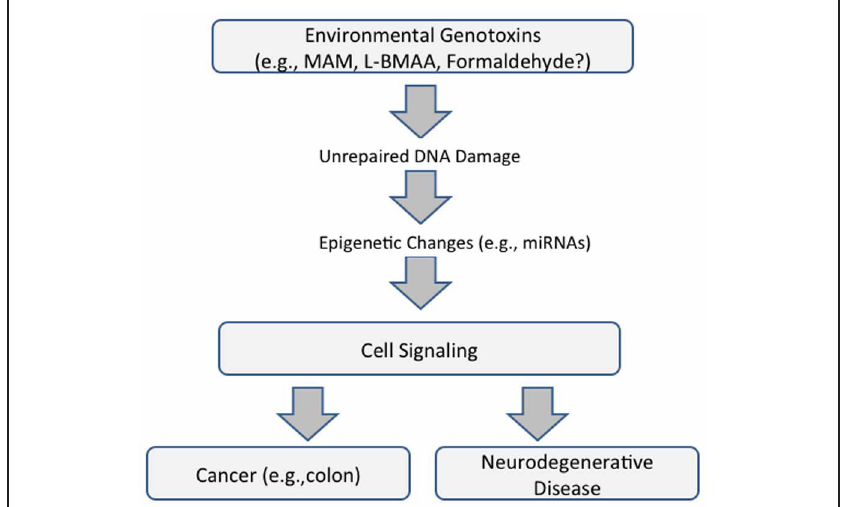
that lack the DNA-repair enzyme O 6 - mG methyltransferase ( Mgmt − / − ) and reduced or absent in mice that overexpress MGMT (Kisby and Spencer, 2011). Motor sistent with the extent of DNA